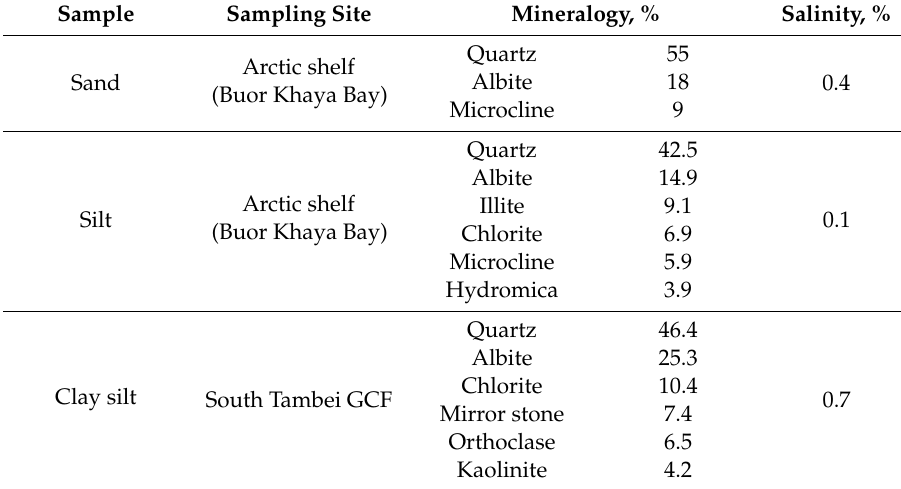
Table 1. Mineralogy and salinity of soil samples.